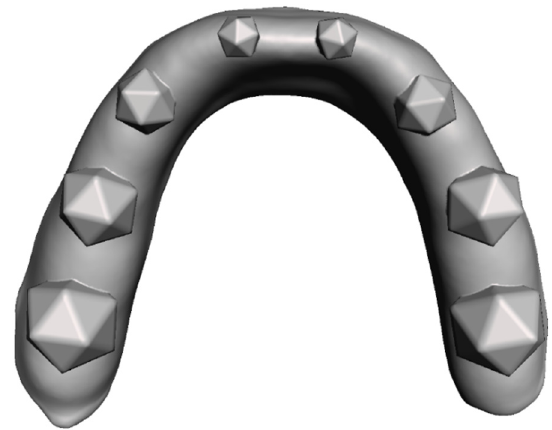
Figure 1. Top view of the 3D model created in the Meshmixer toolkit. To later test the performance of the presented method for different sizes of grinding surfaces, the geometrical bodies varied in size. The triangular surfaces of the icosahe- drons’ faces decreased from posterior to anterior, with respective triangle heights of 5 mm, 4 mm, 3 mm and 2 mm. The base model was produced with an additive